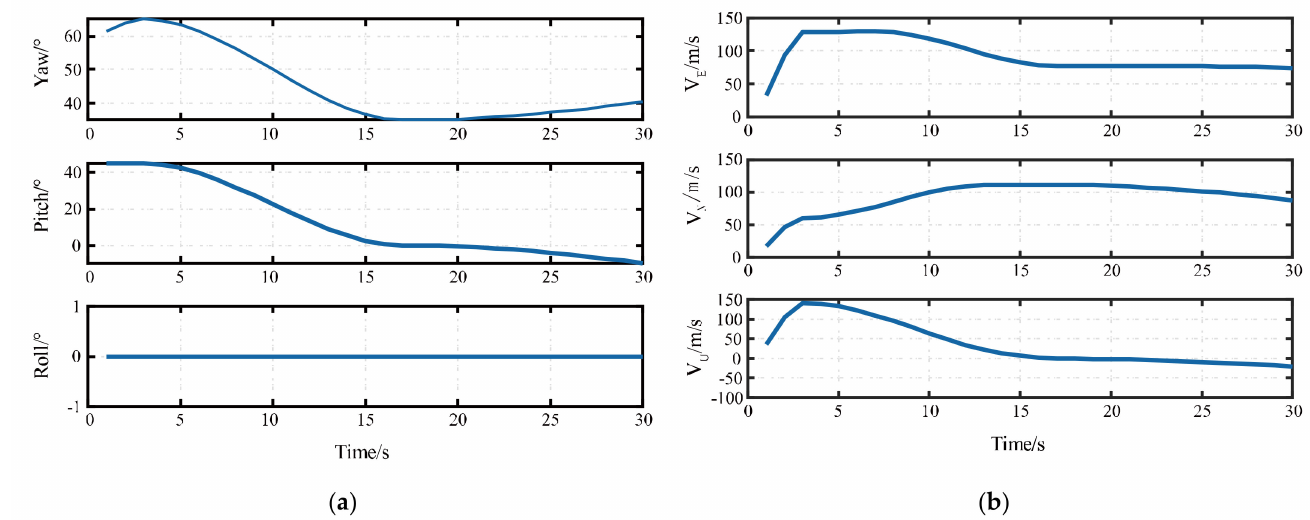
Figure 5. The real-time trajectory of the simulation. ( a ) The real-time attitude of the simulated trajectory. ( b ) The real-time velocity of the simulated trajectory in the direction of east, north, and up, respectively.